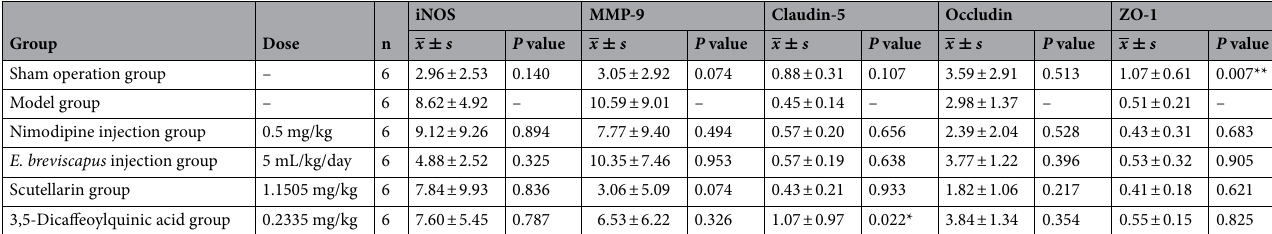
Table 5. Effects of drugs on the expression of iNOS, MMP-9, claudin-5, occludin and ZO-1mRNA levels in the ischemic brain tissue of MCAO